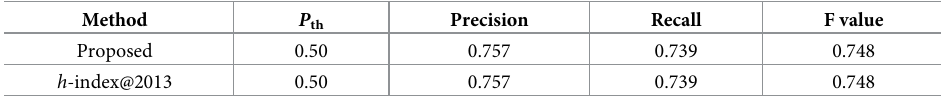
Table 11. Results of future h -index prediction.